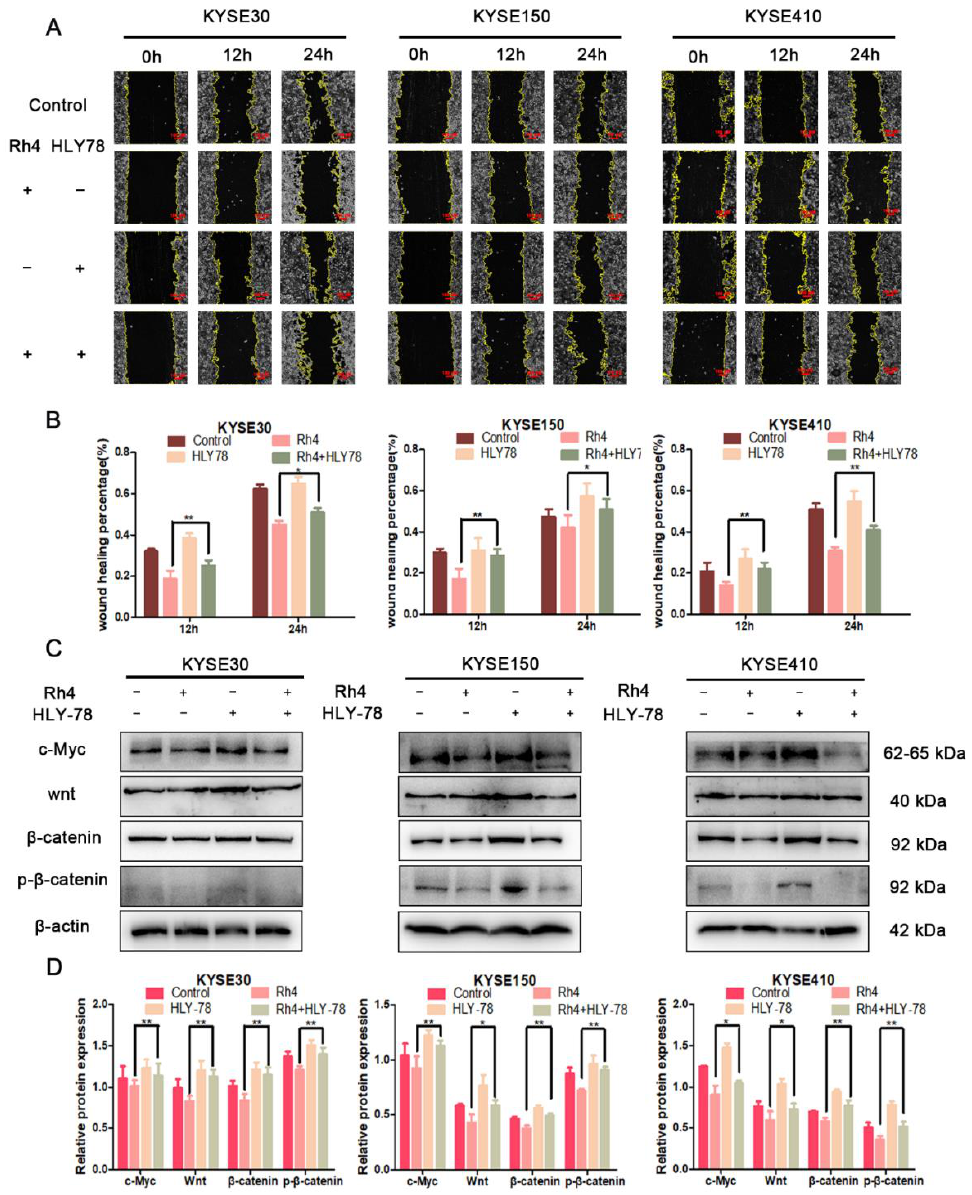
Figure 7. ( A ) Migration images with or without the addition of Rh4(HLY78) at 0, 12, and 24 h. The yellow line is the migration edge. Scale bar = 100 µ m ( B ) Percent wound healing, treatment group vs. control group. ( C ) Protein levels after Rh4 and HLY-78 combined treatment of KYSE30, KYSE150, and KYSE410. ( D ) Bar graphs showing protein expression level. All data are presented as mean ± SD, * p < 0.05 and ** p <